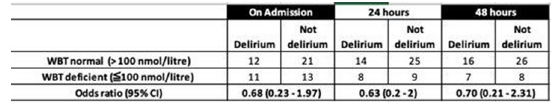
Conclusion. In this small dateset, no relationship could be detected between WBT and delirium occurrence on ICU admission, and 24 and 48 h post admission. The lack of significance with regards to confound- ing variable of sepsis and age could be attributed to small